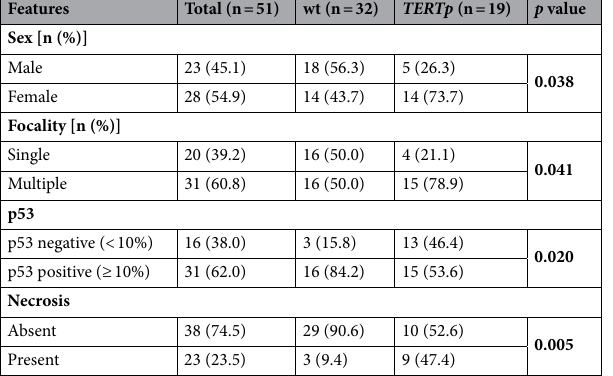
Table 5. Features significantly associated with TERTp mutation status in indolent-type growth pattern cBCCs. Bold - significant difference ( p -value <